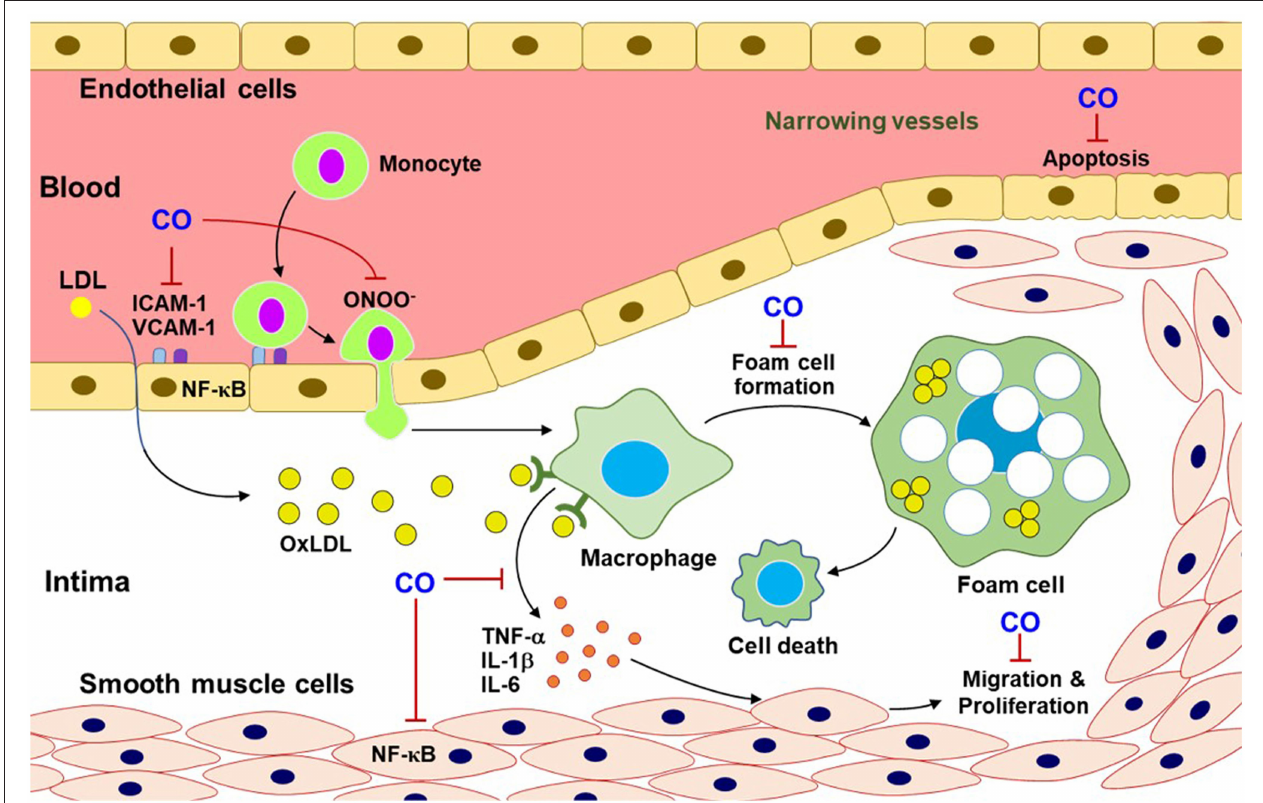
FIGURE 3 | CO inhibits pro-atherosclerotic processes. CO blocks the multifaceted signaling pathways related to atherosclerotic progress. This progress can include monocyte infiltration through adhesion molecules (i.e., ICAM-1 and VCAM-1), macrophage differentiation from monocytes, foam cell formation, and inflammatory cytokine releases and ONOO − production. Additionally, CO reduces EC apoptosis and SMC migration and proliferation. OxLDL, oxidized low-density lipoprotein; ICAM-1, intercellular adhesion molecule-1; VCAM-1, vascular cell adhesion molecule-1; TNF- α , tumor necrosis factor- α ; IL-1 β , interleukin-1 β .